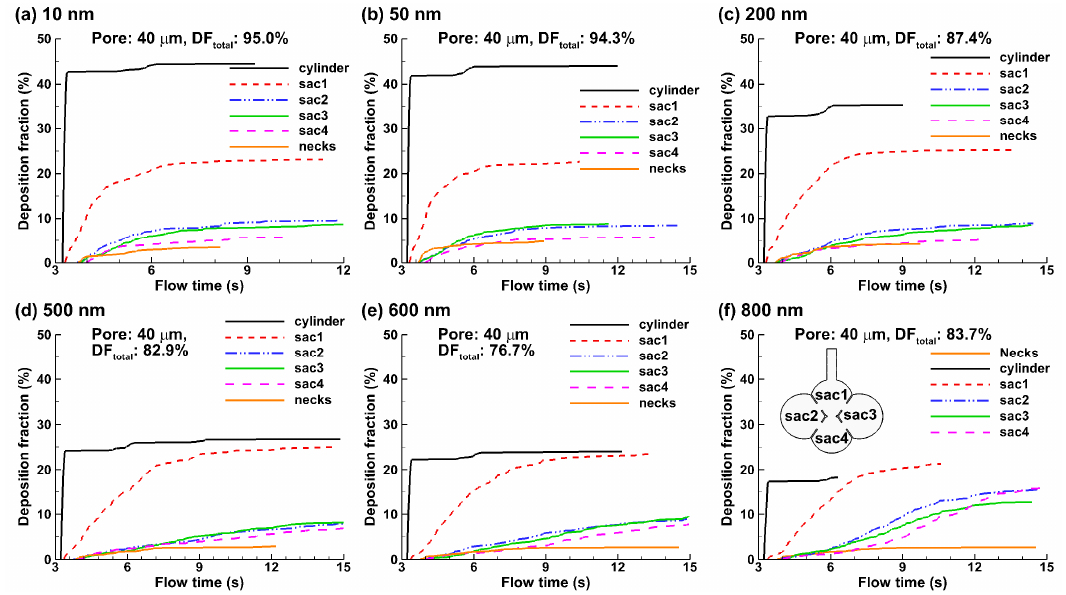
Figure 9. deposition rate with time in the 40-µm-pore alveolar model for nanoparticles of different diameters: ( a ) 10 nm, ( b ) 50 nm, ( c ) 200 nm, ( d ) 500 nm, ( e ) 600 nm, and ( f ) 800 nm. Both total and sub-